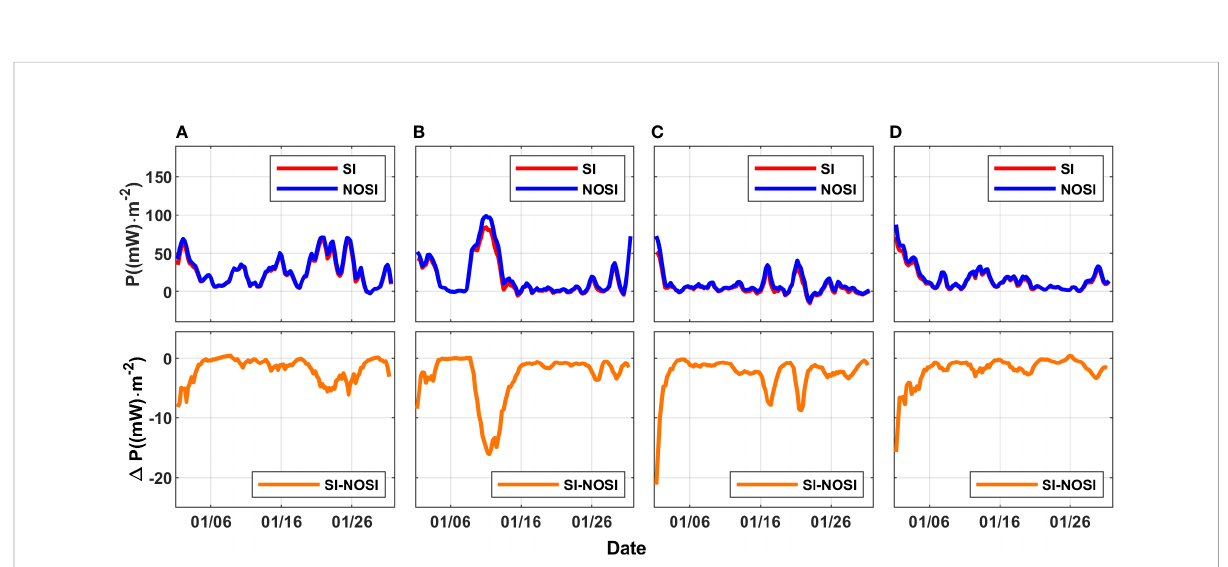
FIGURE 7 The time series of the wind work input P and Δ P of two cases in SI activity region in January (A) 2017, (B) 2018, (C) 2019, (D)